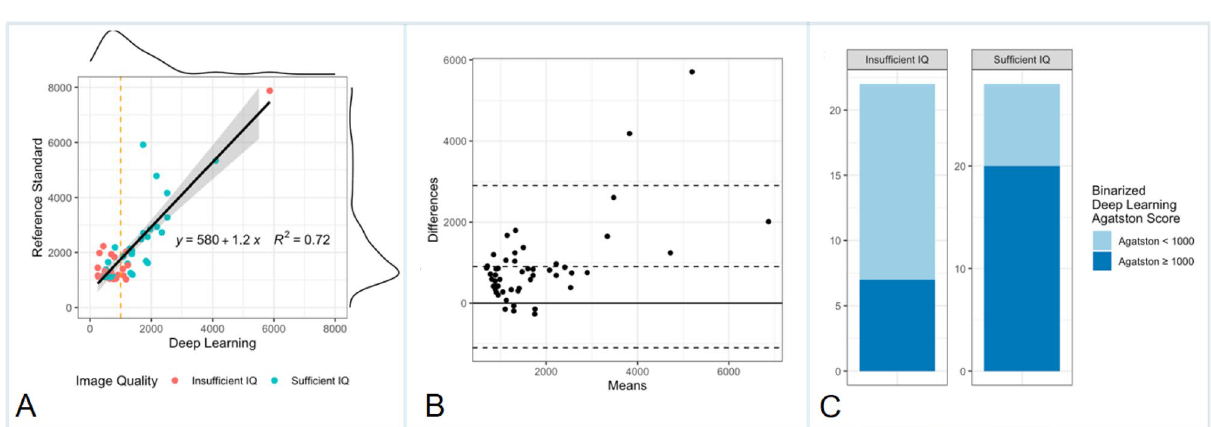
Figure 3. Visual representation of study data. This figure visualizes the study data, including the data of the high CACS group (n = 50): linear regression model ( A ), Bland–Altman analysis ( B ), as well as frequency of patients with a DL-based Agatston score of below or above 1000 stratified by image quality ( C